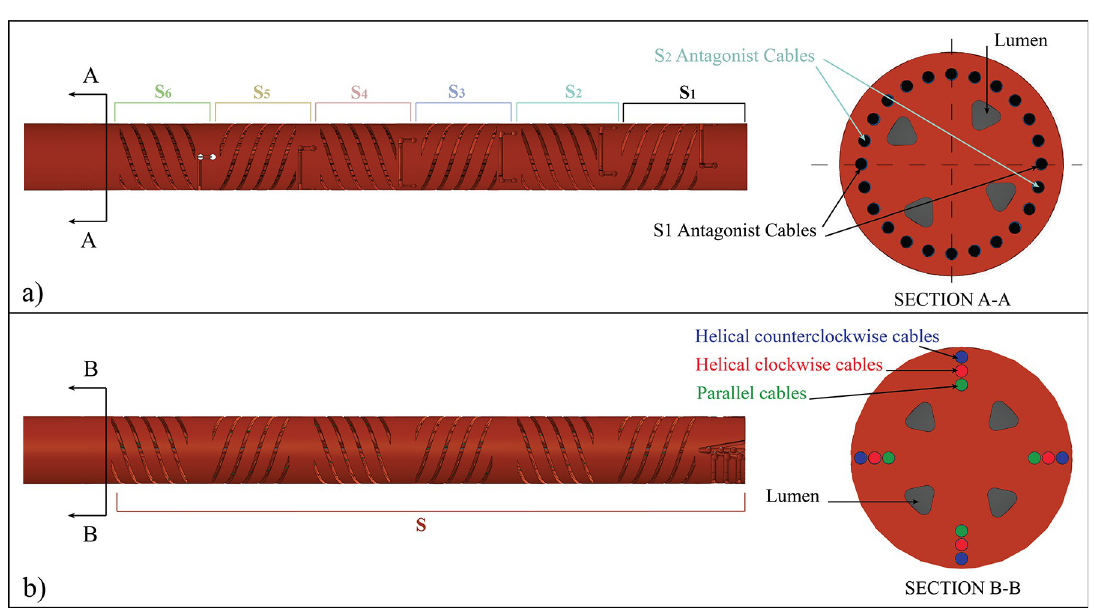
Fig 4. Cross-section of the shaft for the parallel and the multi configurations. a) In the parallel configuration all cables are equally distant from the central backbone Segments S are numbered from 1 to 6. In the multi configuration, cables are concentrically placed at three different radii to avoid overlapping. S represents the steerable shaft.